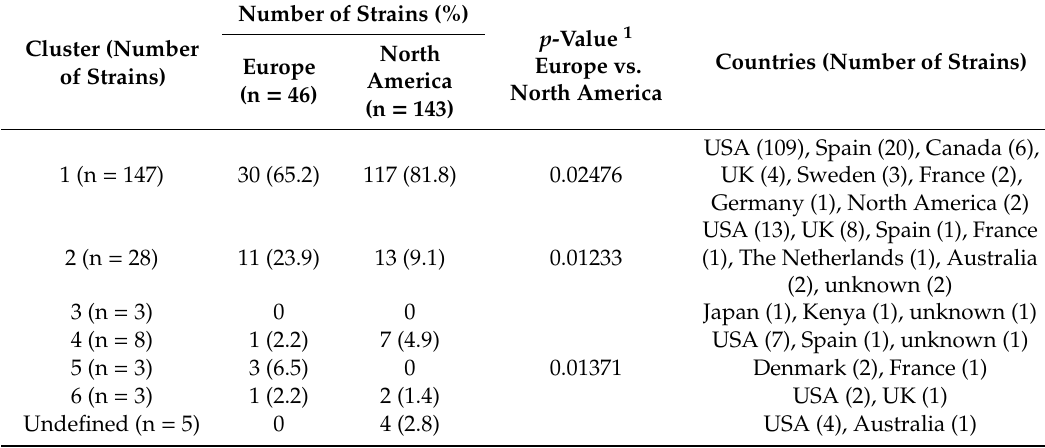
Table 6. Cluster distribution of the 197 studied ST372 strains according to